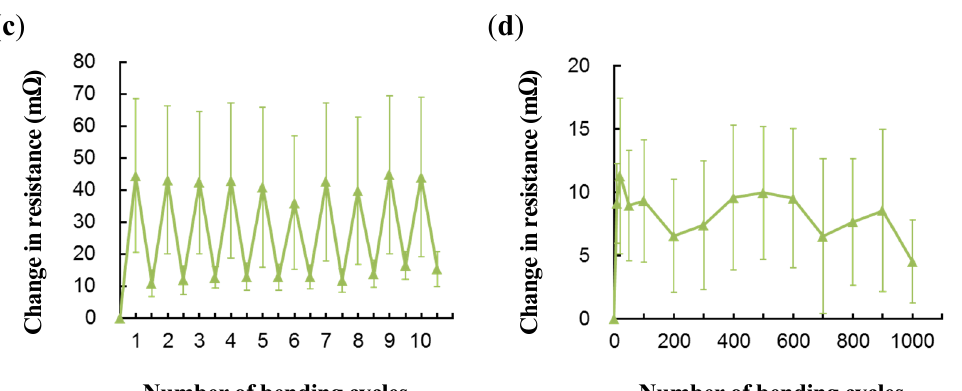
Figure 20. Bending test with the FPC in which electrodes were removed: ( a ) photograph of the thinned out FPC (182 electrodes); ( b ) cross-sectional image of the junction; ( c ) continuous measurements; and ( d ) intermittent